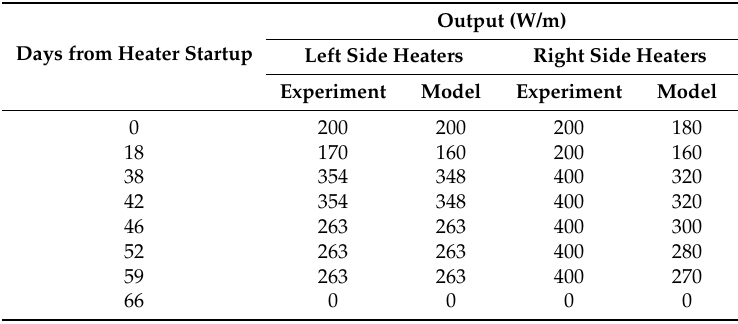
Table 3. Heater powers used in the experiment and in the model [35,36].